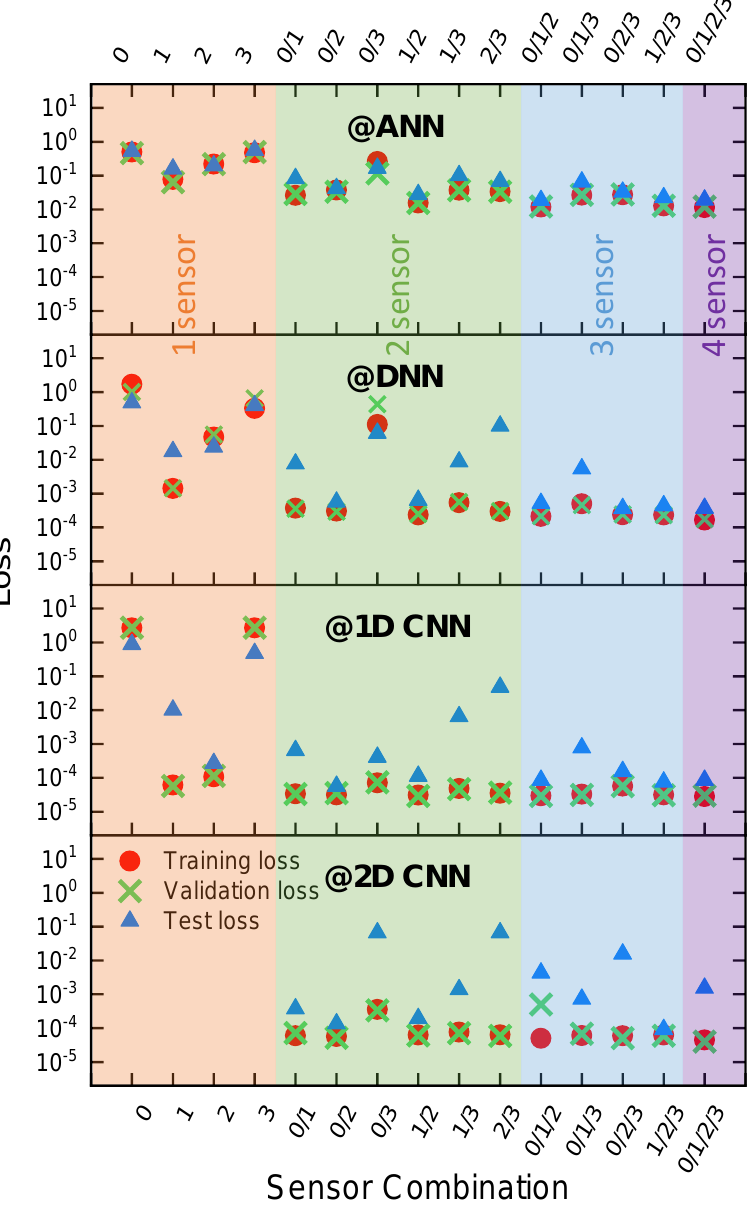
Figure 6. Loss information evaluated as a function of the number of sensors and deep learning algorithms employed in gas detection/classification (based on the calculation at 1000 epochs): ANN (2-layer structure), DNN (4-layer structure), 1D CNN, and 2D CNN.